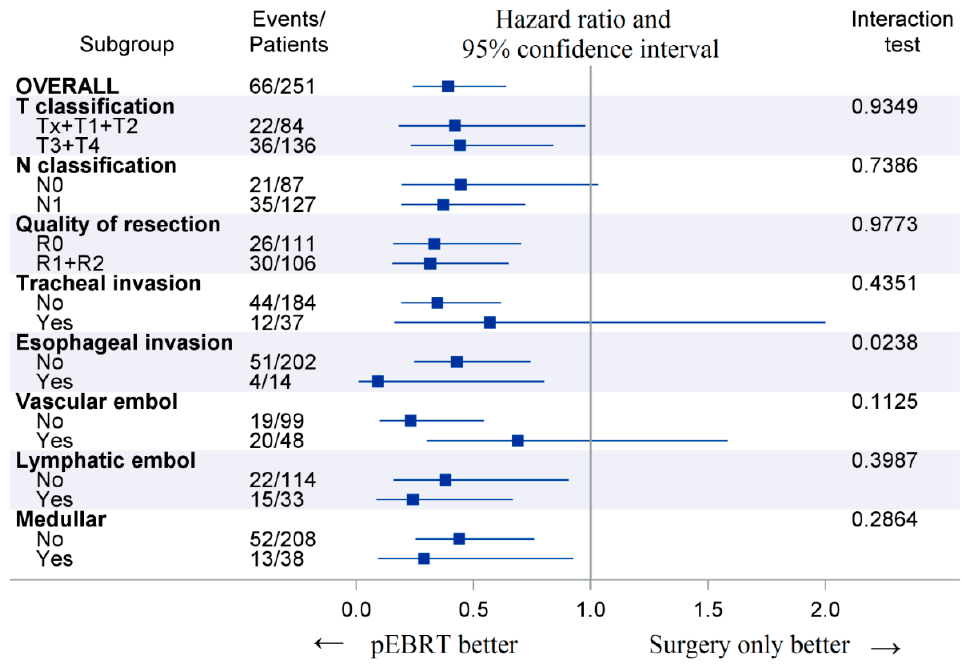
Figure 2. Forest plots displaying postoperative external beam radiotherapy (pEBRT ) effects on locoregional failure across subgroups. Legend: Events represent the number of locoregional failures at last follow-up. The p -value is from the test statistic for testing the interaction between pEBRT and any subgroup parameter.